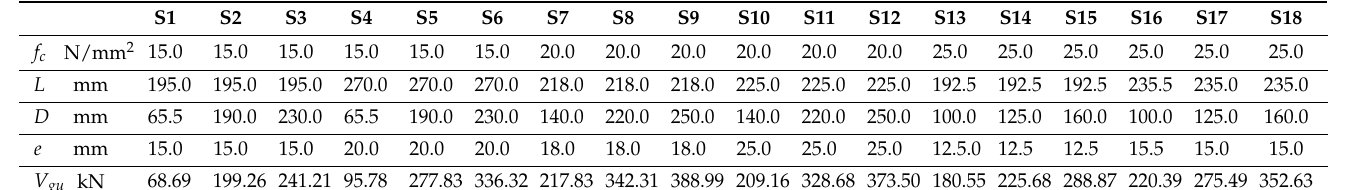
Table 1. Case studies: shear strength of 18 anchor groups post-installed into concrete. The first row indicates the number of the case Study (S1–S18). The rows from the second to the second to last report the data of each case study (i.e., concrete compressive strength and anchor group geometry). The last row reports the shear strength V gu of each anchor group. The first and second columns report the symbol of the mechanical and geometrical parameters, and the relevant units. Each column from the third to the last reports a case study completely—data and result.